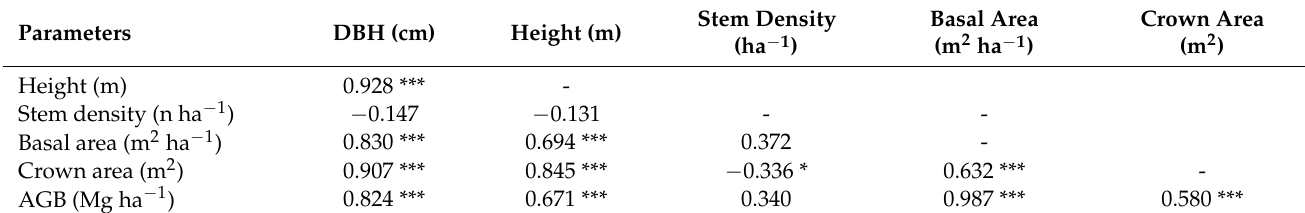
Table 3. The correlation between the stand structure variables and aboveground biomass of the mangrove stand.